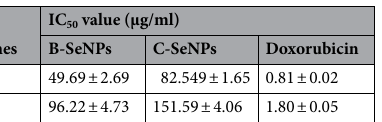
Table 6. Anti-cancer activity of B-SeNPs and C-SeNPs.